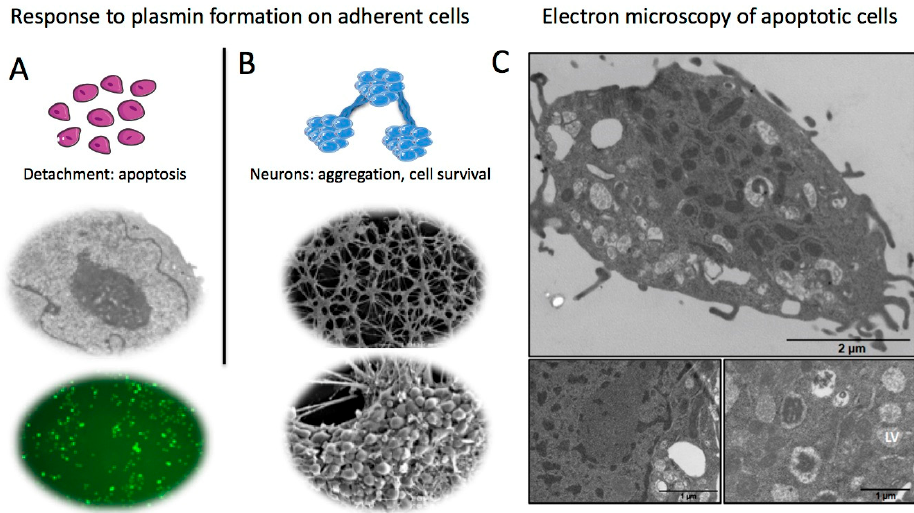
Figure 3. Consequences of plasmin formation on adherent cells. ( A ) Detachment of CHO-1 cells from the substratum upon degradation of extracellular matrix proteins (fibronectin, laminin) by membrane-bound plasmin. Most detached adherent cells enter apoptosis as indicated by nuclear condensation (electron microscopy) and TUNEL positive cells. ( B ) Plasminogen activation on mouse cortical neurons. Upon detachment from the substratum, neurons form interconnected clusters that resist to apoptosis and survive longer. ( C ) Cell changes typical of apoptosis as visualised by transmission electron microscopy (CHO-1 cells). The main and lower panels show late apoptotic changes (chromatin condensation, compaction and fragmentation of the nucleus, vacuolisation of the cytoplasm and lysis vesicles (LV)) [42,50].